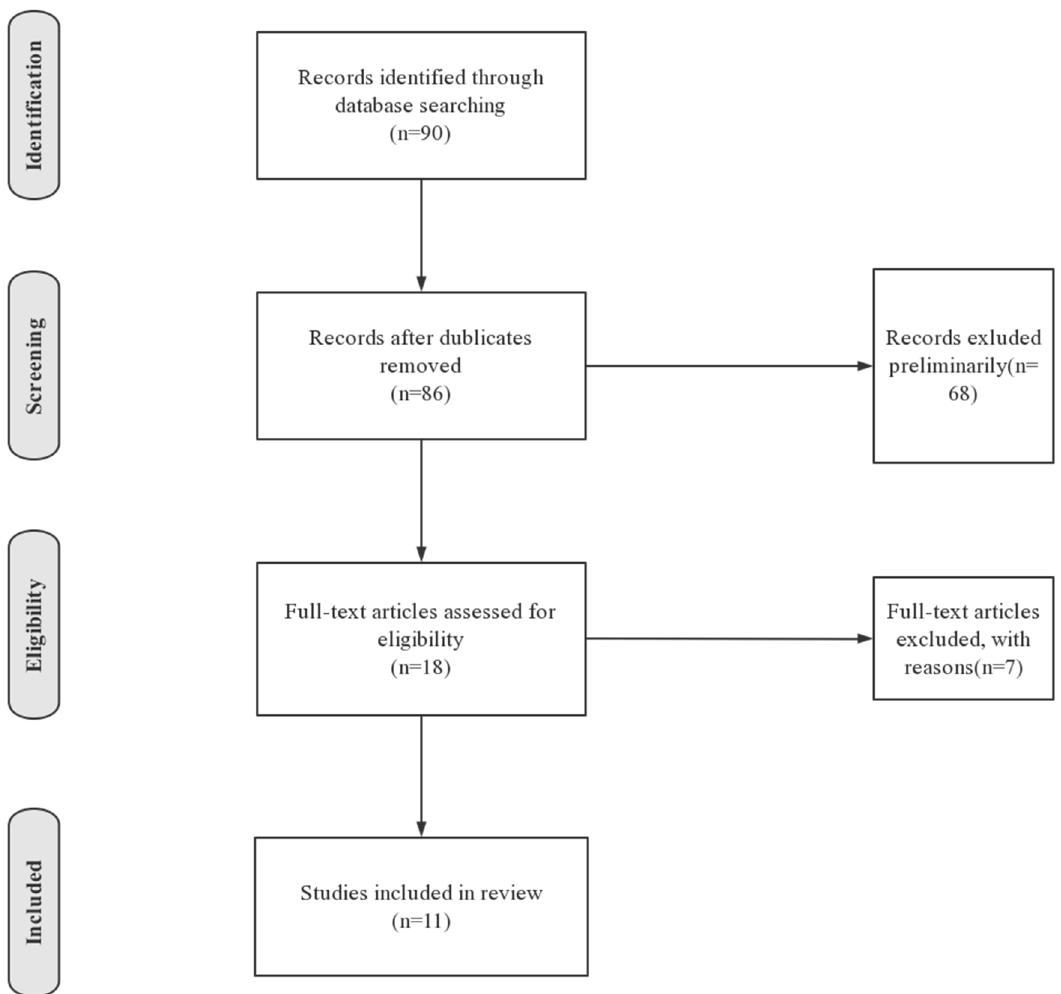
Figure 1. Flow diagram for the process of searching existing literature.